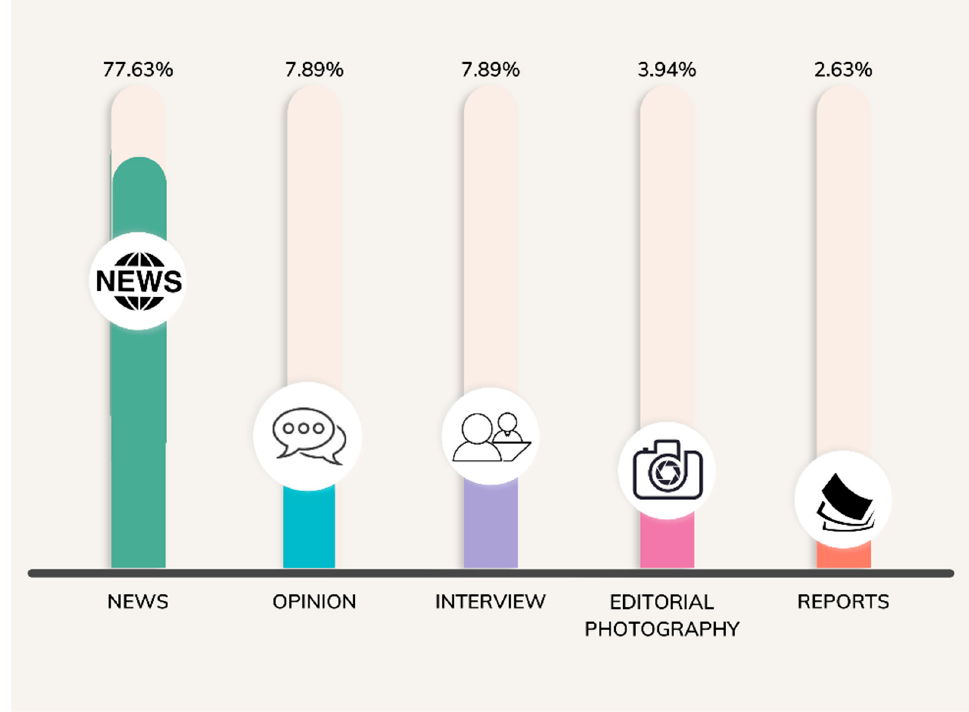
Figure 2. Journalistic genres in the information about COVID-19.